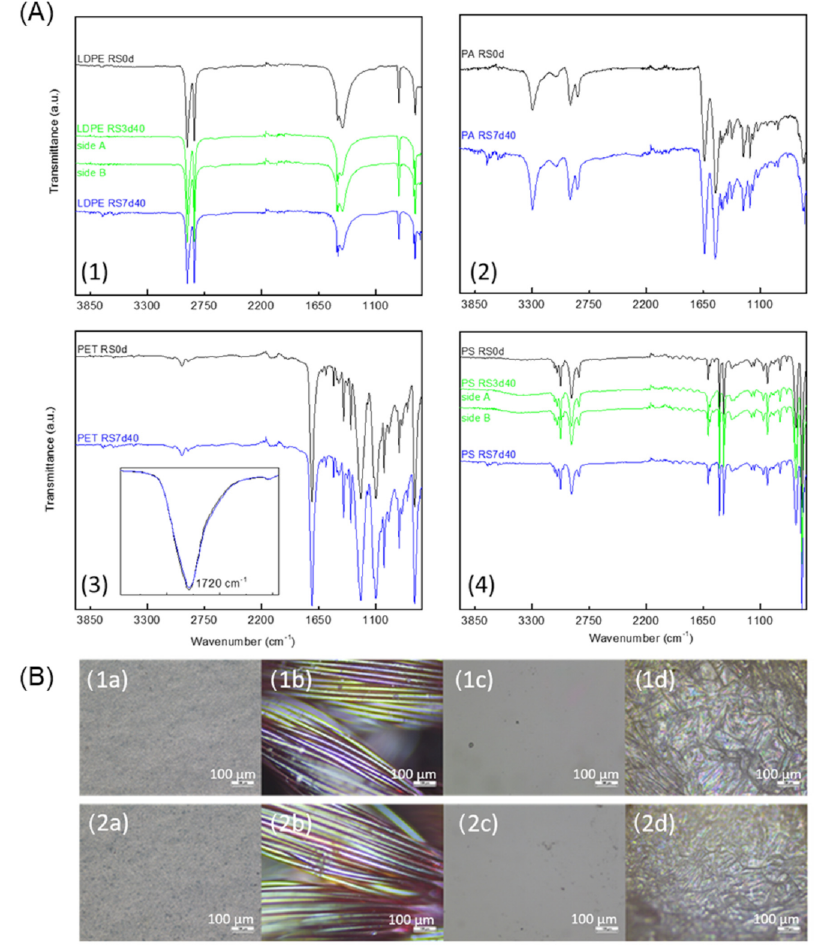
Figure 3. ( A ) FTIR spectra of RS samples of LDPE (1), PA (2), PET (3) and PS (4) at different test times in H 2 O 2 at 15% ( v / v ) at 40 ◦ C and ( B ) Optical microscopy images of RS samples (LDPE (a), PA (b), PET (c) and PS (d)), before the test (1) and after one week in H 2 O 2 15% (v / v ) (2). Samples are identified as RSXdY, where X and Y indicate the number of days and the treatment temperature,